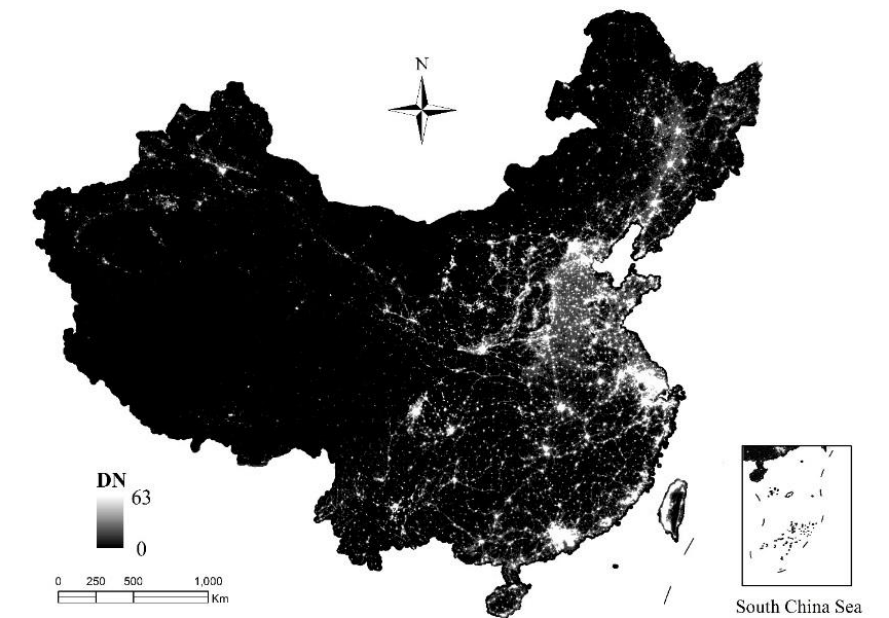
Figure 2. The DMSP-OLS nighttime light data of China in